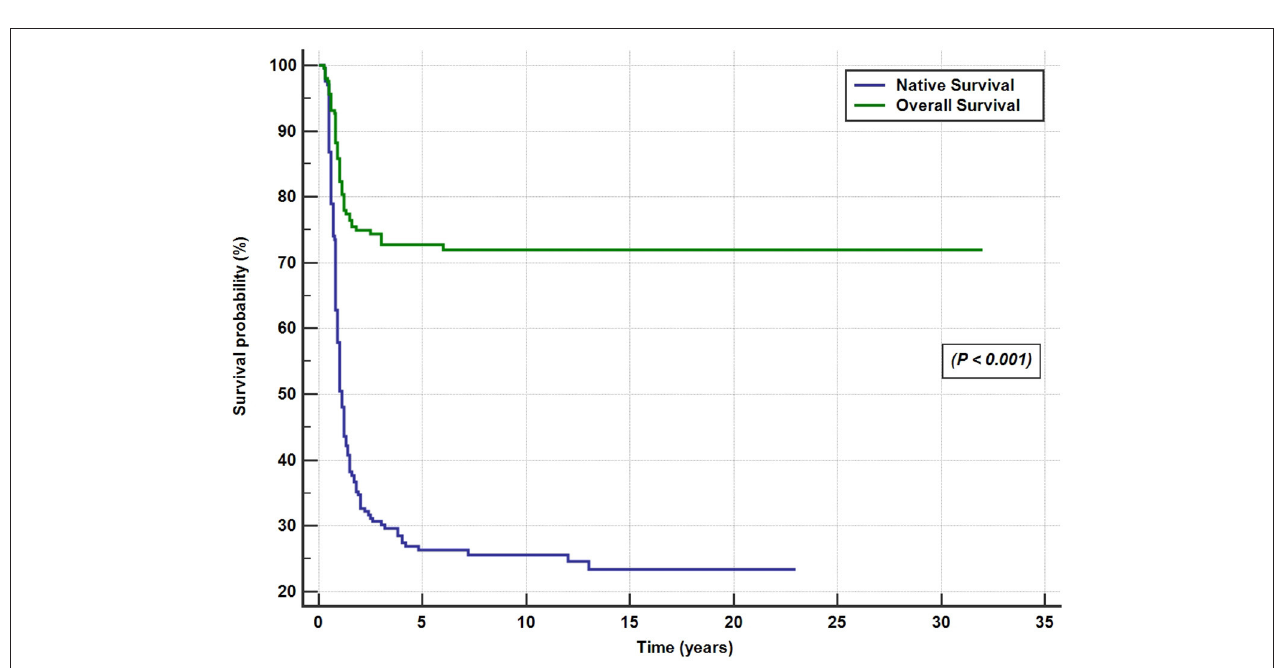
FIGURE 4 | Overall and native liver survival Kaplan–Meier curves for the 204 biliary atresia